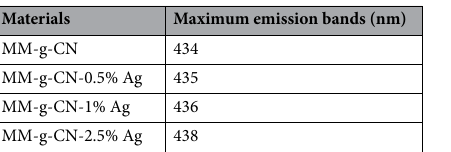
Table 7. Maximum emission bands of pristine MM-g-CN and modified with Ag